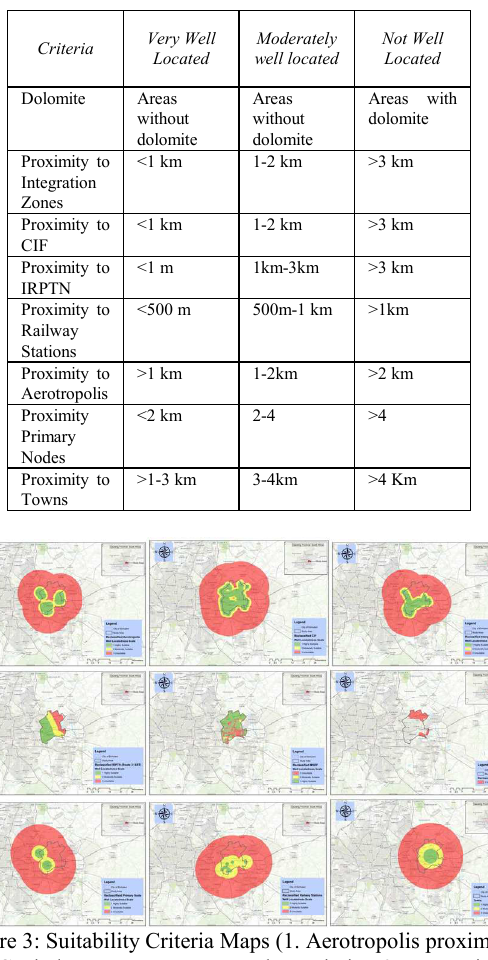
Table 2: Criteria and rule sets